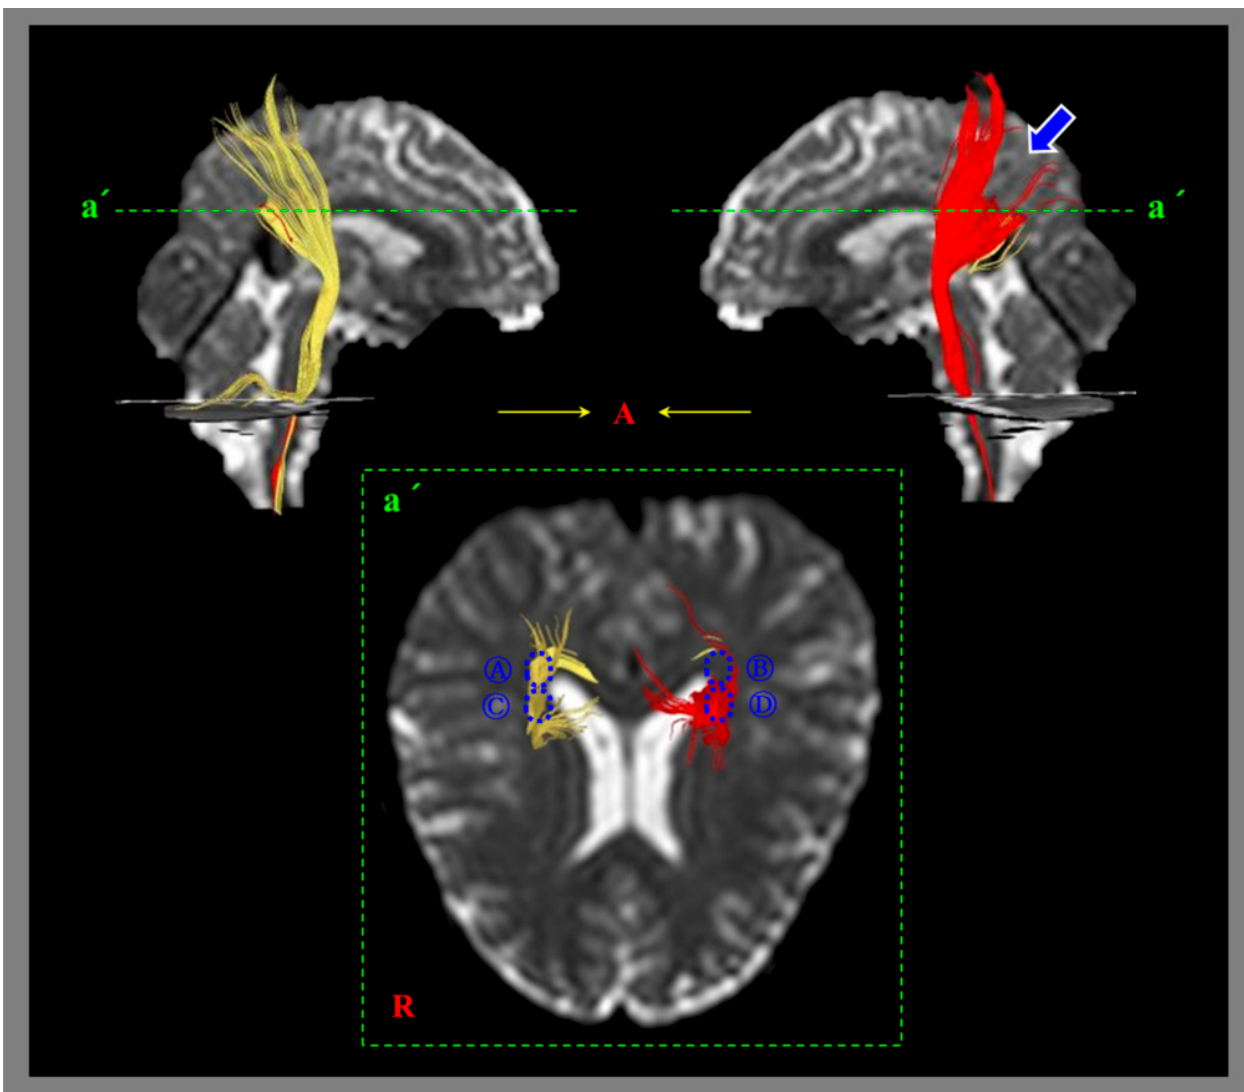
Figure 2. Possible false measurement of diffusion tensor imaging parameters in a partially torn corticospinal tract in a patient with mild traumatic brain injury. The left corticospinal tract shows partial tearing (arrow) at the subcortical white matter. When a researcher measures diffusion tensor imaging parameters using the region of interest (ROI) method, if the ROI is placed in the partially torn area (B), traumatic axonal injury of the left corticospinal tract can be detected, whereas if the ROI is placed in the normal-appearing area (D), traumatic axonal injury of the left corticospinal tract cannot be detected (reprinted with permission from [13]).